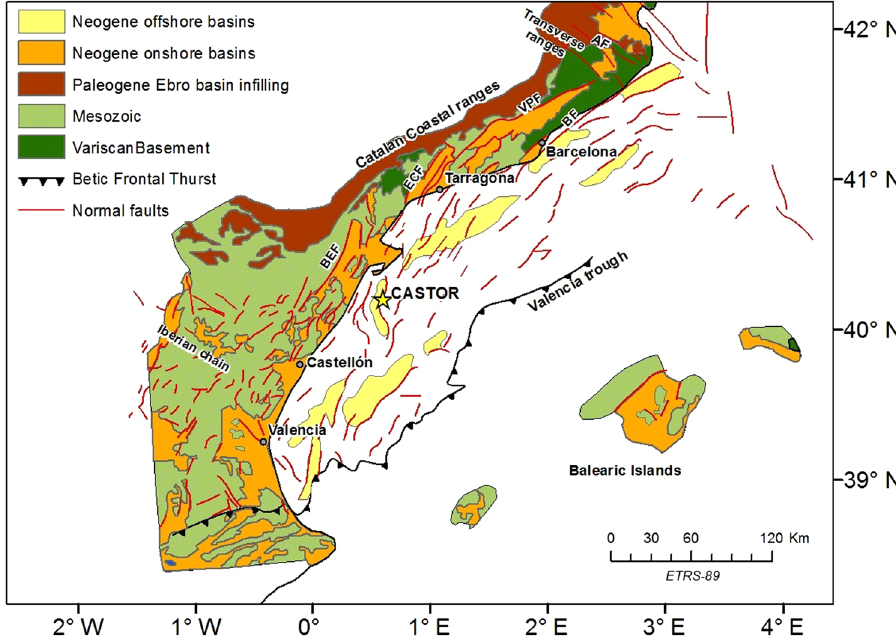
Figure 2. Simplified geological framework around the Castor platform. AF: Amer fault; BF: Barcelona fault; VPF: Vallès-Penedès fault; ECF: El Camp fault; BEF: Baix Ebre fault. The figure was generated by using the ESRI software, ArcGIS for desktop, version 10.1. Data source: Perea 15 . Based on Roca 16 and Roca and Guimerà 17